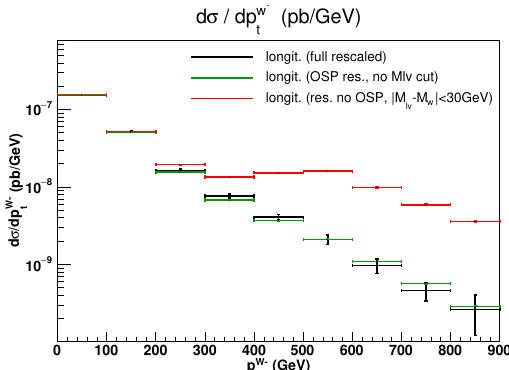
Figure 13. Transverse momentum distribution of longitudinally polarized W (cid:0) for M WW > 1000 GeV. The full result is shown in black; the OSP one, in green. The red points are obtained neglecting non resonant diagrams and requiring j M ‘(cid:23) (cid:0) M W j < 30 GeV. The red and green results have been obtained with a (cid:12)xed polarization for the negatively charged W . The black points have been computed from a generation of the full process, extracting the longitudinal fraction f 0 in each transverse momentum bin through a Legendre expansion, cf. section